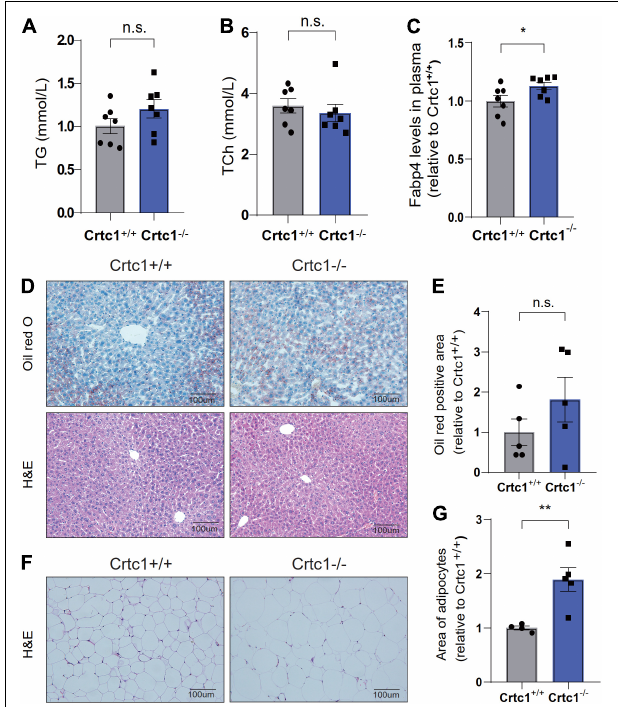
FIGURE 5 | Abnormal lipid metabolism in Crtc1 − / − mice. (A) Plasma triglyceride (TG). (B) Plasma total cholesterol (TC). (C) Plasma fatty acid binding protein 4 (FABP4) in Crtc1 + / + and Crtc1 − / − mice at the age of 8 months. (D) Oil Red O and H&E staining of the liver tissues from Crtc1 + / + and Crtc1 − / − . (E) Quantification of the Oil Red positive area of liver. (F) H&E staining of white adipose tissue from Crtc1 + / + and Crtc1 − / − mice. (G) Quantification of the mean area for adipocyte. Data are mean ± SEM; * P < 0.05; ** P < 0.01 and n.s. indicates no significant difference.